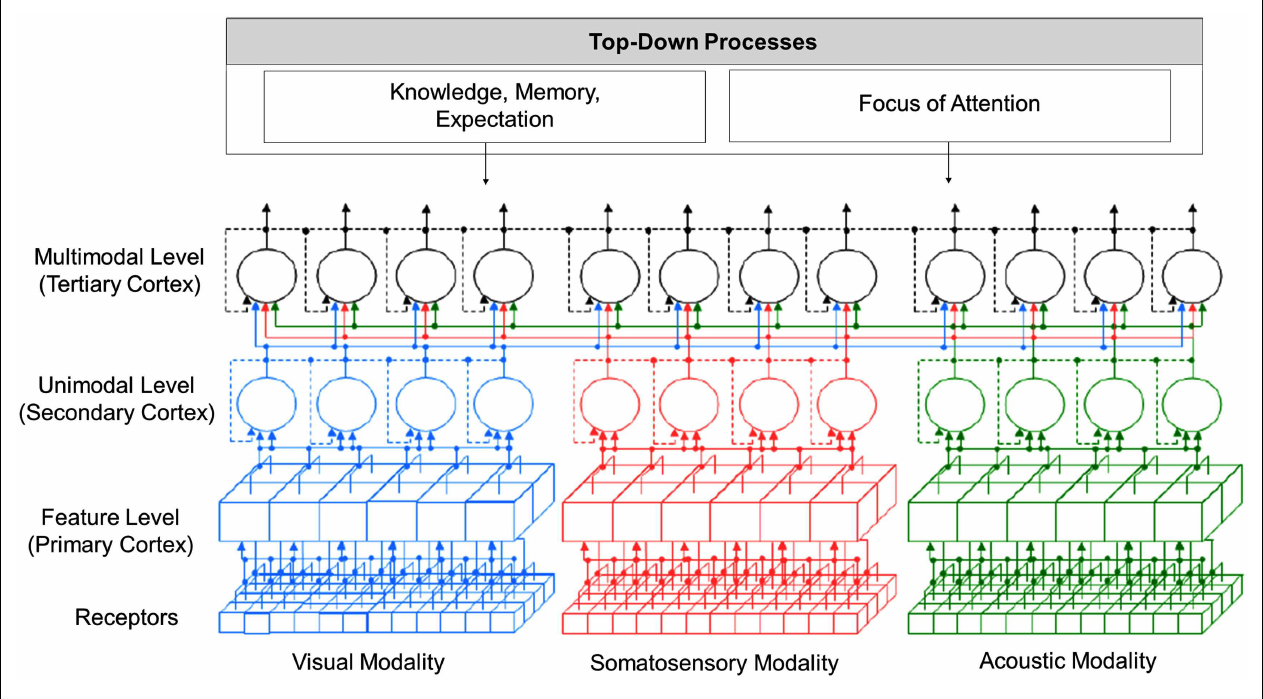
FIGURE 4 | Overview of “integrative” solution to the binding